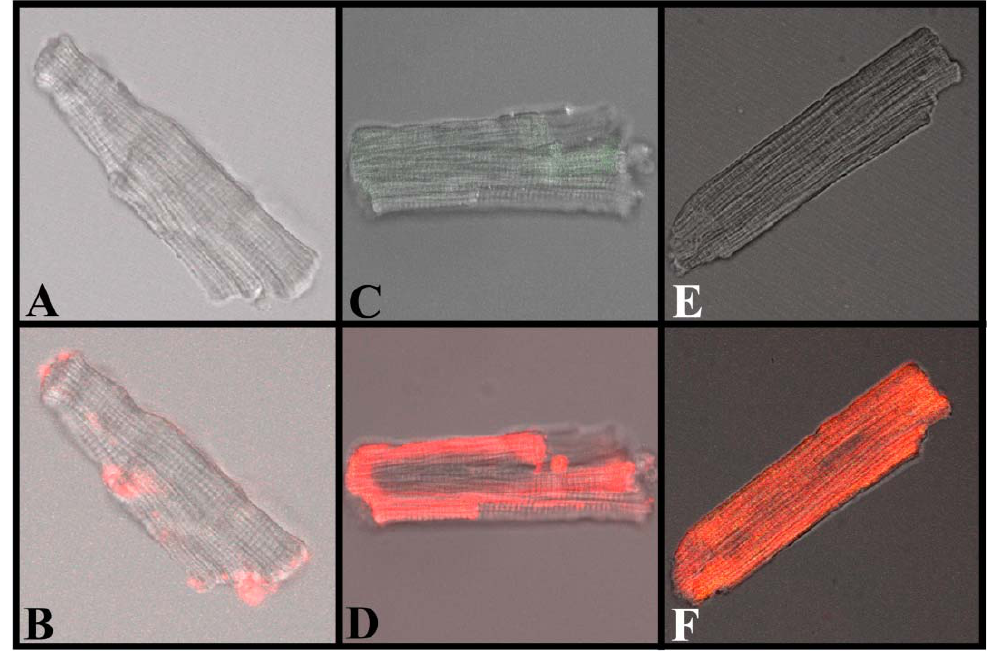
Figure 7. Translocation of IpTxa from external to intracellular compartments of intact mouse ventricular myocytes. All images represent the transmitted light image of the cardiomyocytes (C and B also show Fluo-3 fluorescence). A, C, and E were imaged at the beginning of the protocol, before the start of Alexa-IpTxa perfusion. B, Same cell as A, but after 10 minutes of Alexa-maleimide (1 μ M) perfusion. D, Same cell as C, but after 10 minutes of Alexa-IpTxa (1 μ M) perfusion. F, Same cell as E, but after 30 minutes of Alexa-IpTxa (1 μ M) perfusion.